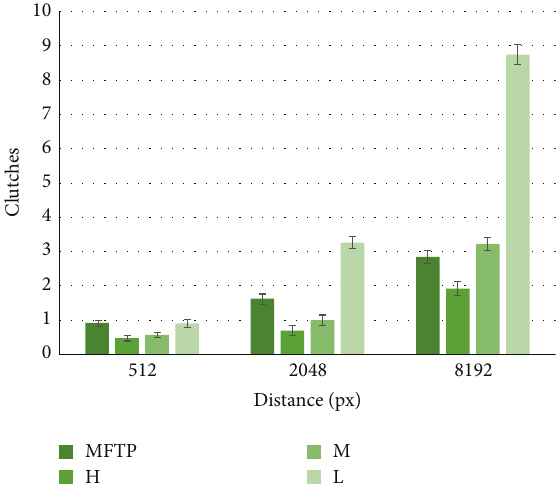
Figure 11: Clutching rates for each technique and each target dis- tance (error bars: 95% confidence